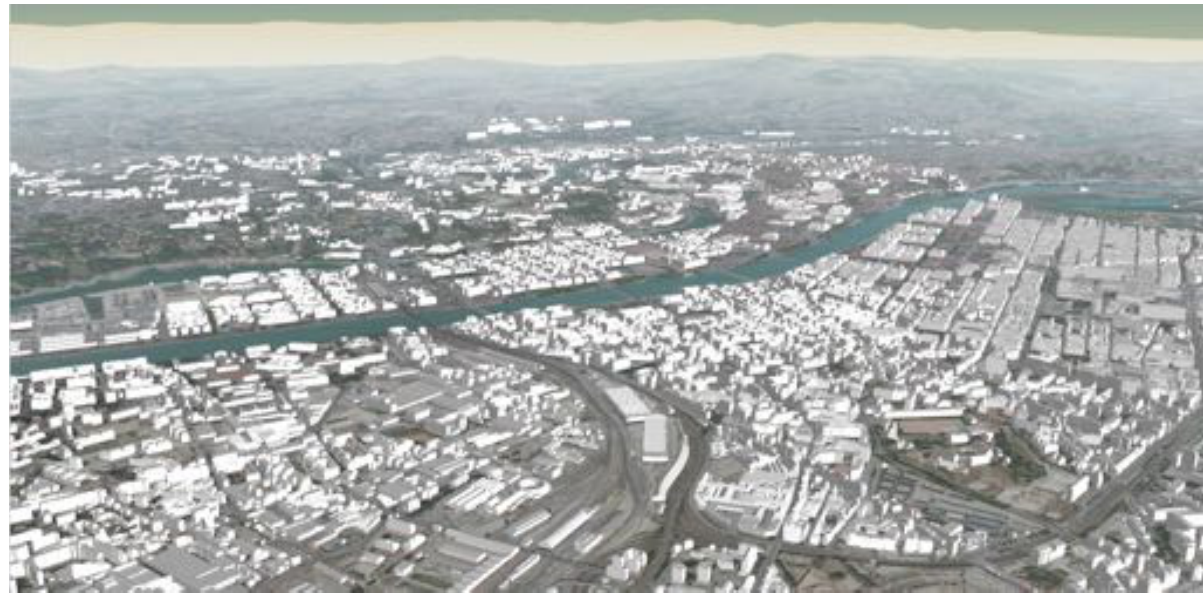
Figure 9: Screenshot of our web application based on Cesium. In the foreground, most of the buildings are loaded, while only the most prominent are displayed in the background.